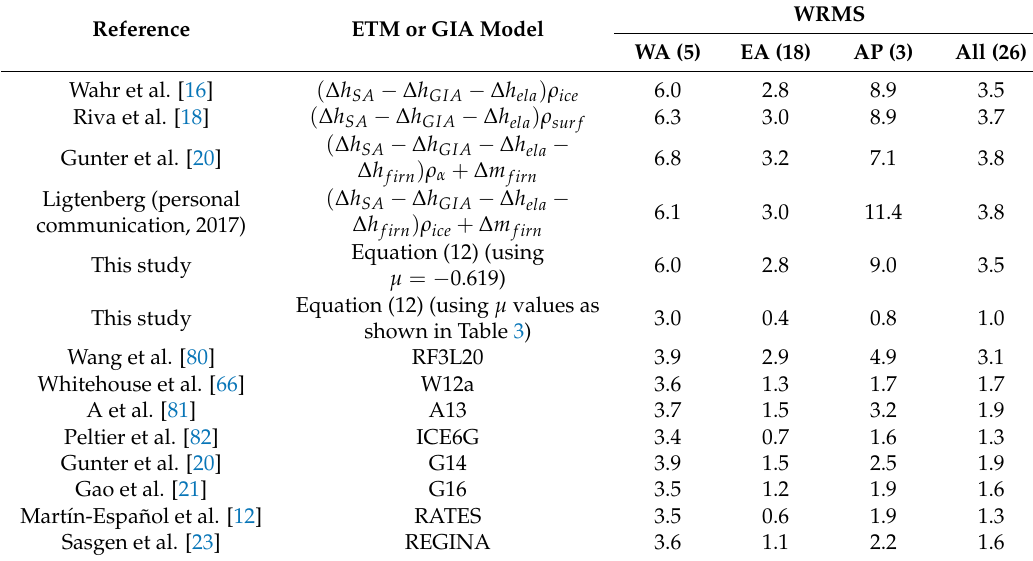
Table 2. Comparison of the estimated glacial isostatic adjustment (GIA) uplift rates derived from different elevation-to-mass (ETM) models and other GIA solutions with 26 GPS sites over Antarctica. ∆ h ∆ m firn and firn represent the surface height and mass change of the firn, and ρ α is an assigned density. The unit of weight right mean square (WRMS) is mm/yr, only δ ∆ h GPS of WRMS. The number in parenthesis denotes the total quantity of GPS sites within each region.